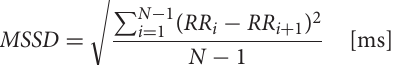
to apply correctly, an algorithm to measure the ratio of